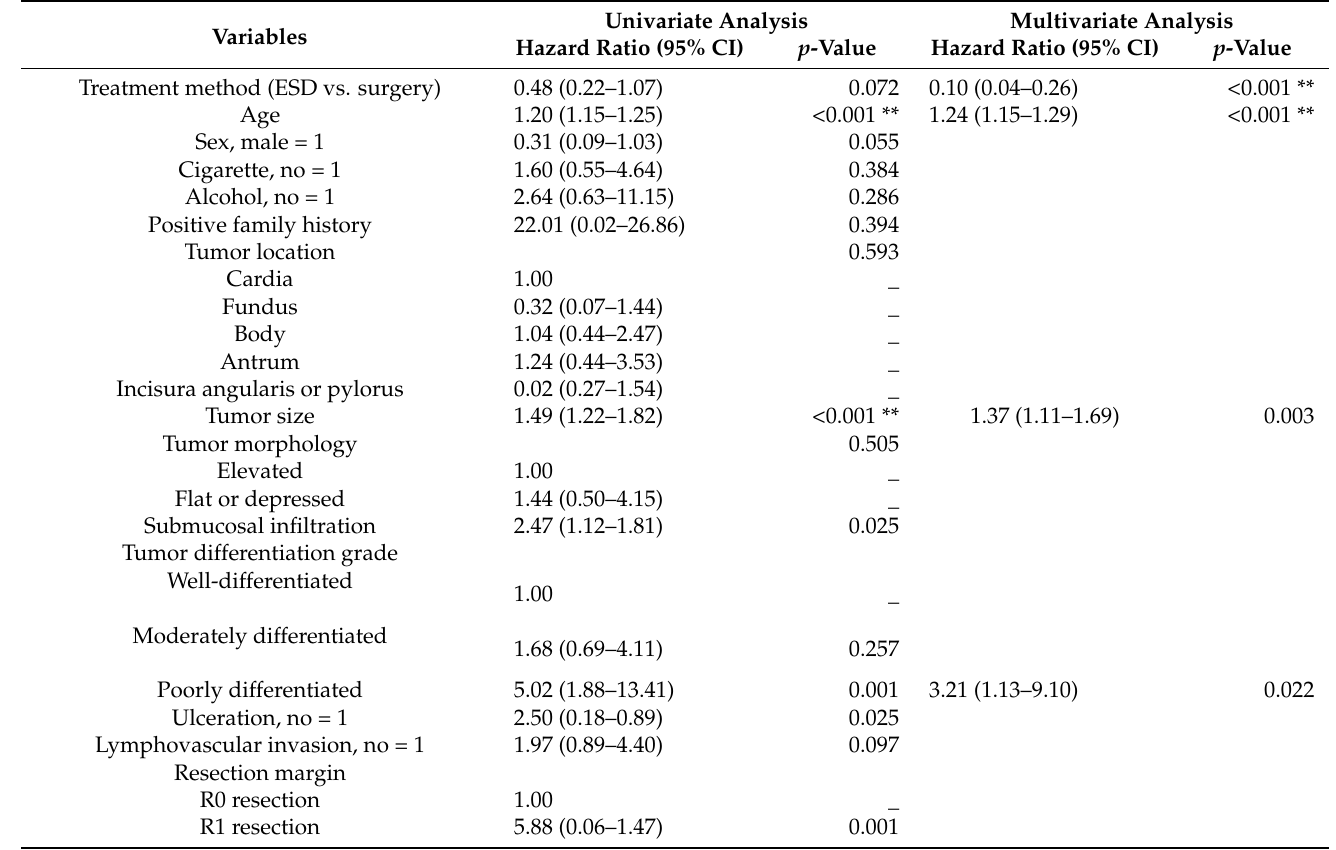
Table 5. Univariate and multivariate regression analyses of overall survival for propensity score- matching